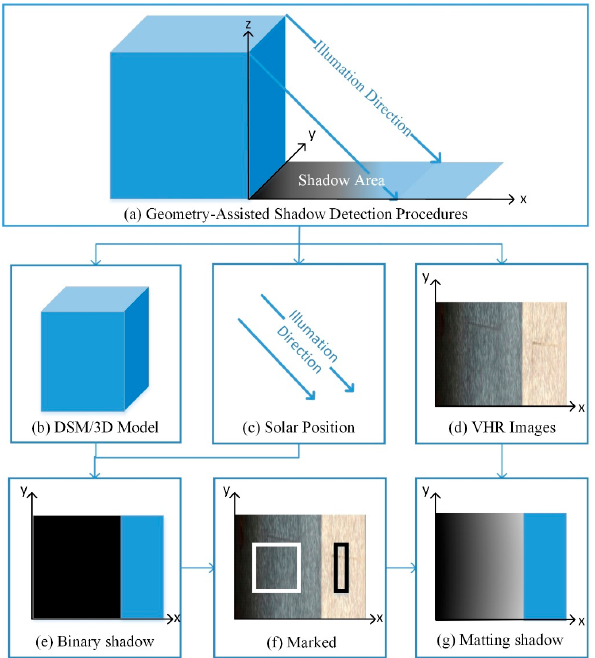
Figure 1. The procedure of the proposed geometry-assisted shadow detection method.